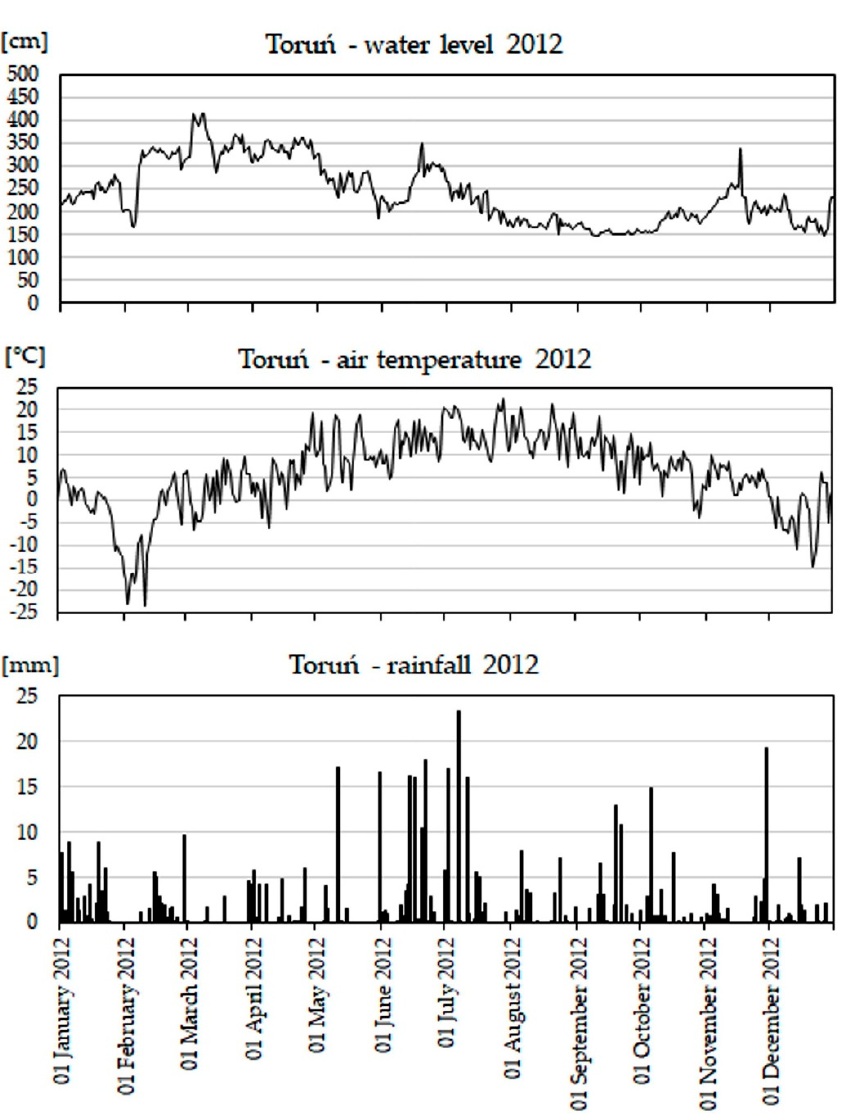
Figure 3. Water levels at the Toru´n water gauge, year 2012, and air temperature and precipitation at Toru´n Meteorological Station 12250 WMO (World Meteo Orgnisation), year 2012. Own elaboration. Data source: www.pogodynka.pl.